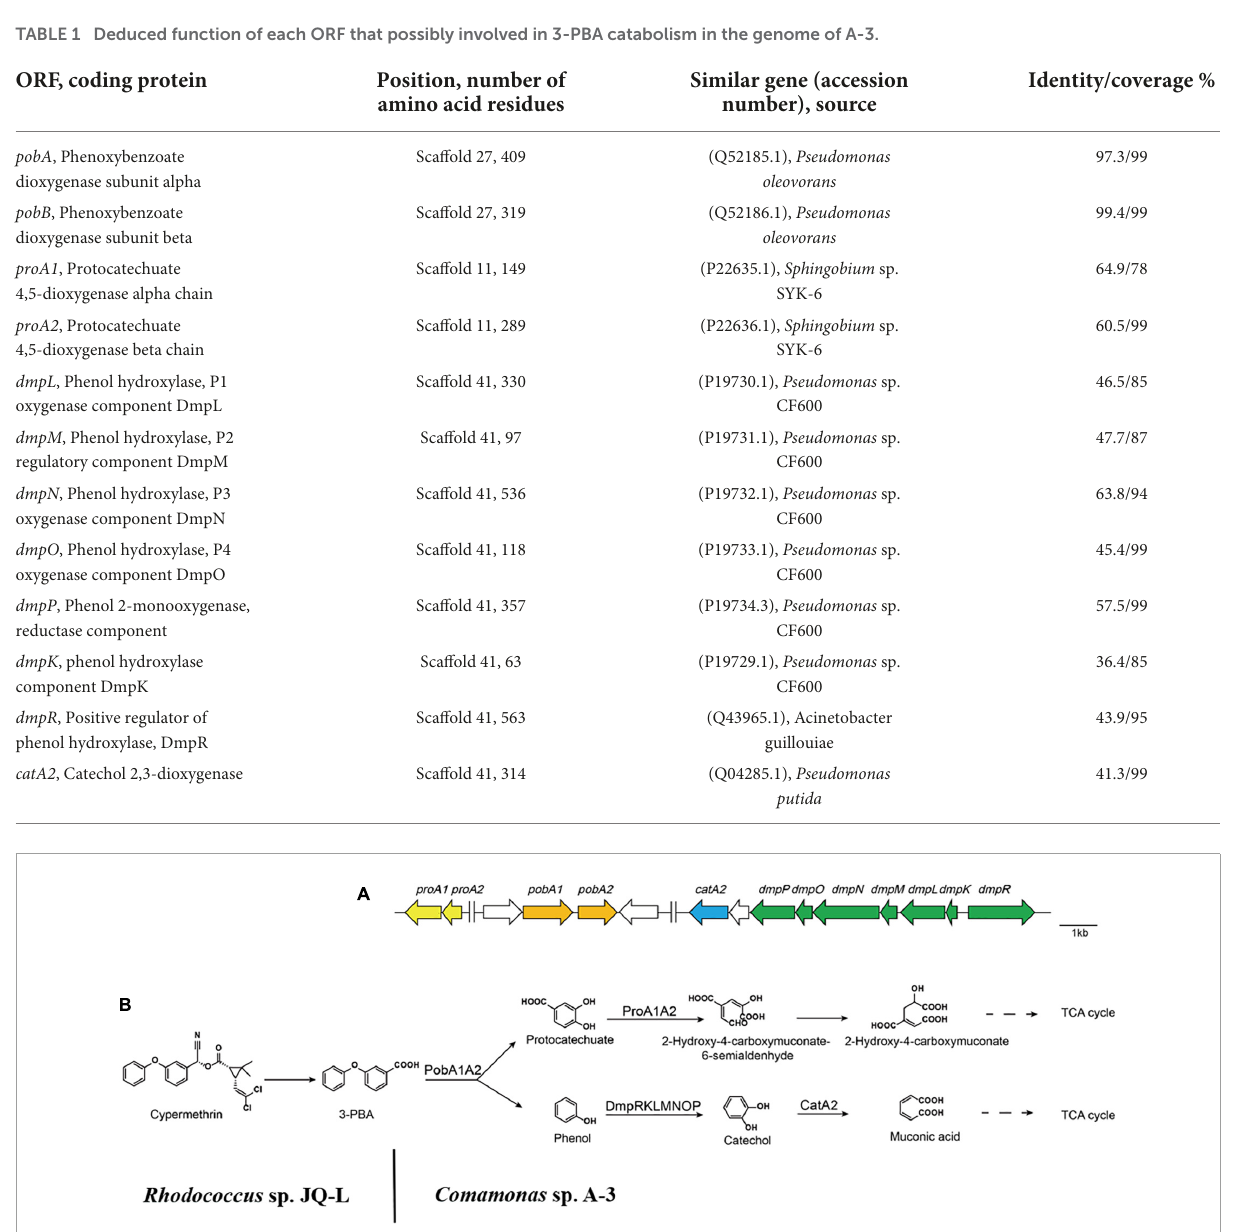
FIGURE7 The catabolism of cypermethrin by co-culture of JQ-L and A-3. (A) Organization of genes possibly involved in the catabolic pathway of 3-PBA in Comamonas sp. A-3. Arrows indicate the size and transcriptional direction of each gene. (B) The proposed complete catabolic pathway of cypermethrin by co-culture of Rhodococcus sp. JQ-L and Comamonas sp.